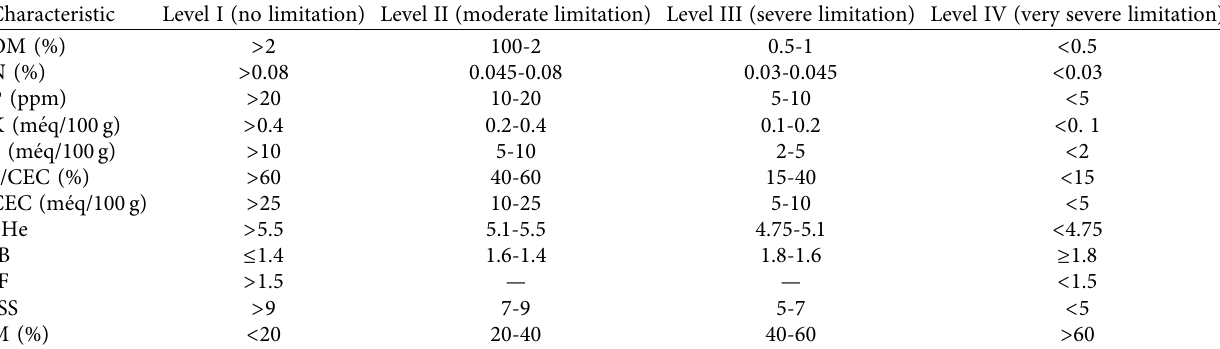
Table 3: Criterion for assessing soil fertility classes [62] modified by Reference [63].